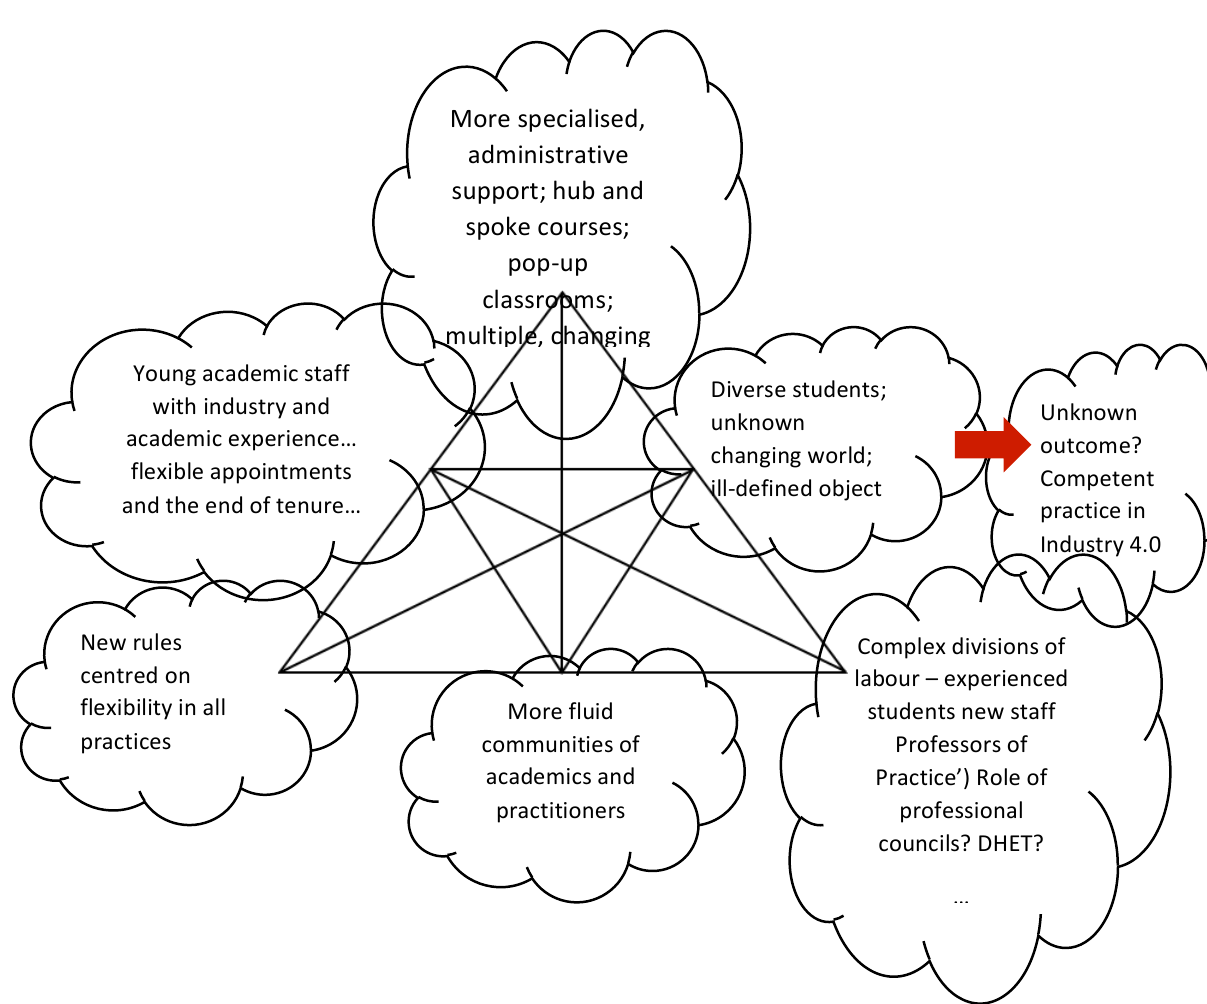
Figure 5: Confusion and a lack of clarity in changing the teaching and learning activity